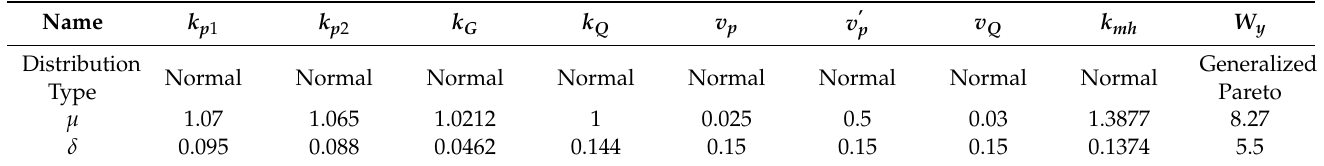
Table 3. Basic variables for each statistical